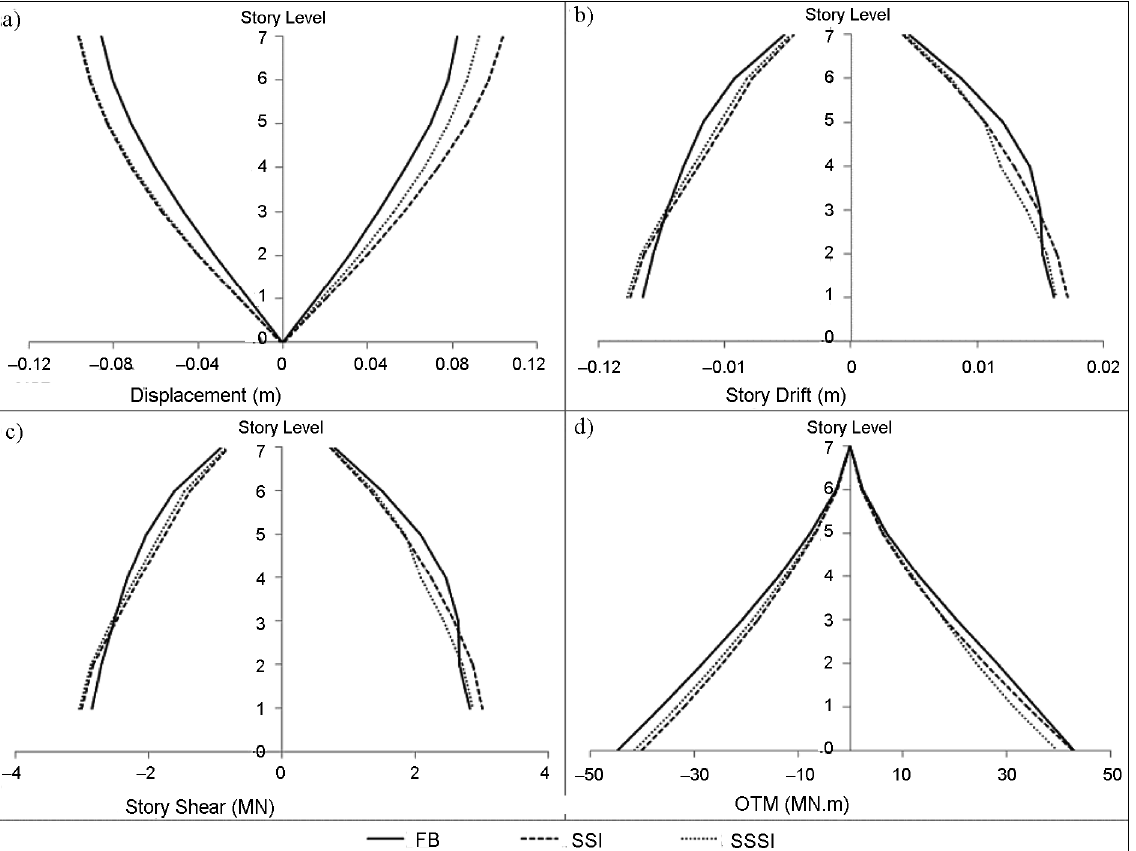
Fig. 4. Envelops of maximum responses of the